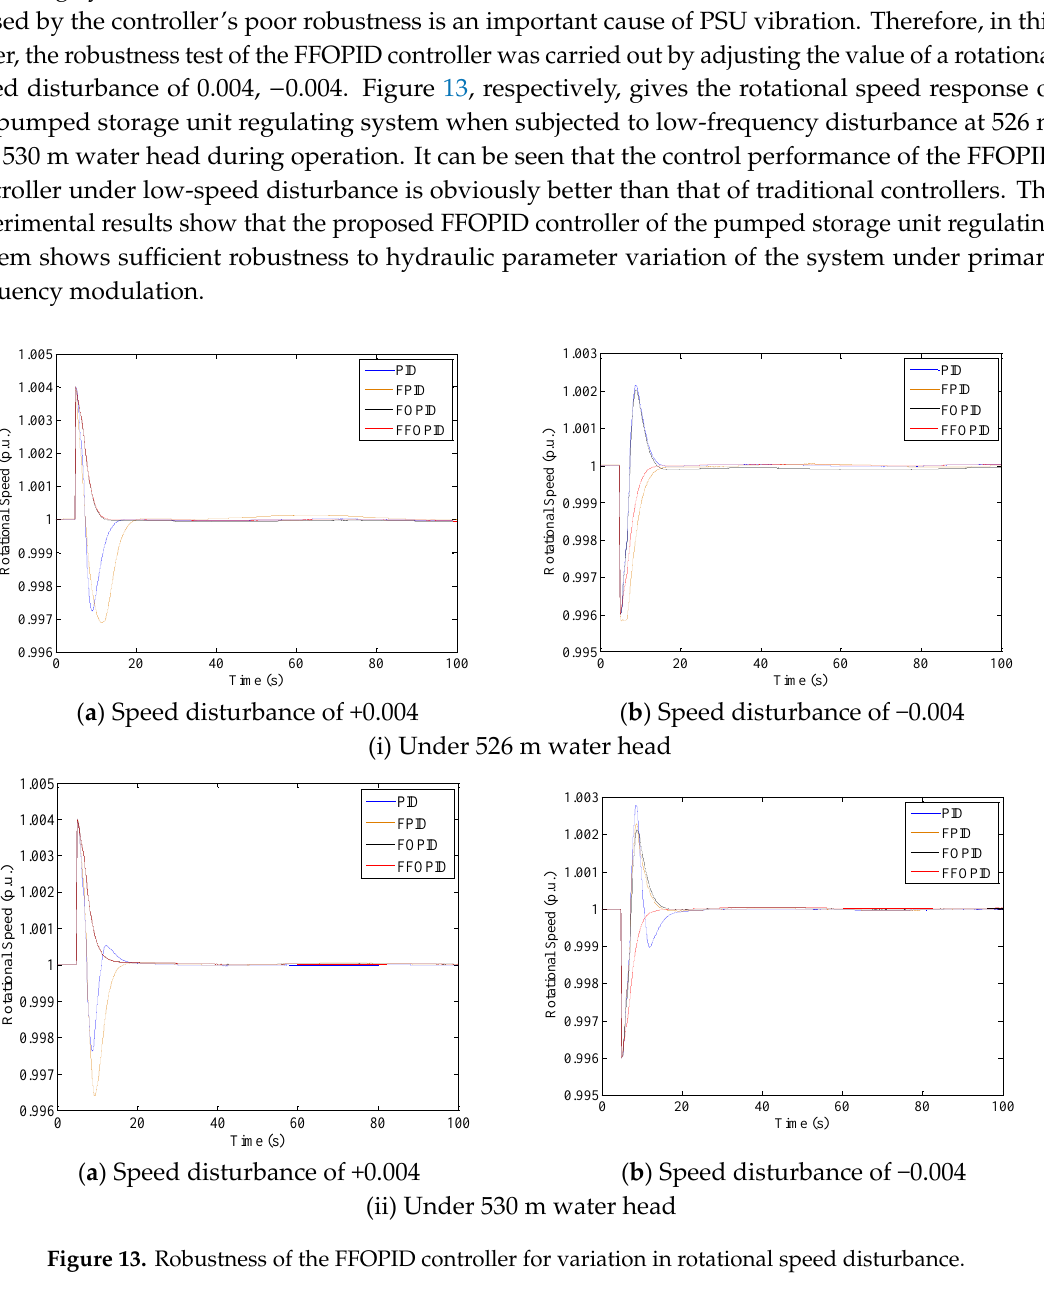
Figure 12. Transient processes of the pumped storage unit (PSU) with different controllers: ( a ) Mechanical Torque; ( b ) Guide Vane Opening; ( c ) Water Hammer of Up Surge Chamber; ( d ) Water Hammer of Down Surge Chamber.